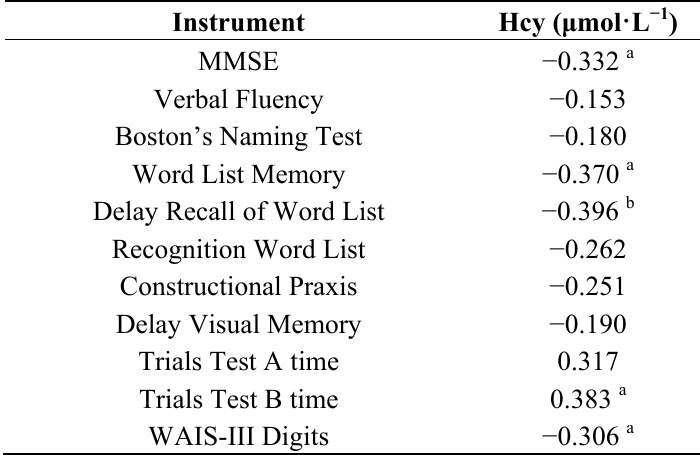
Table 5. Correlations between homocysteine (Hcy) levels vs. cognitive performance, using different instruments. In each analysis, n =